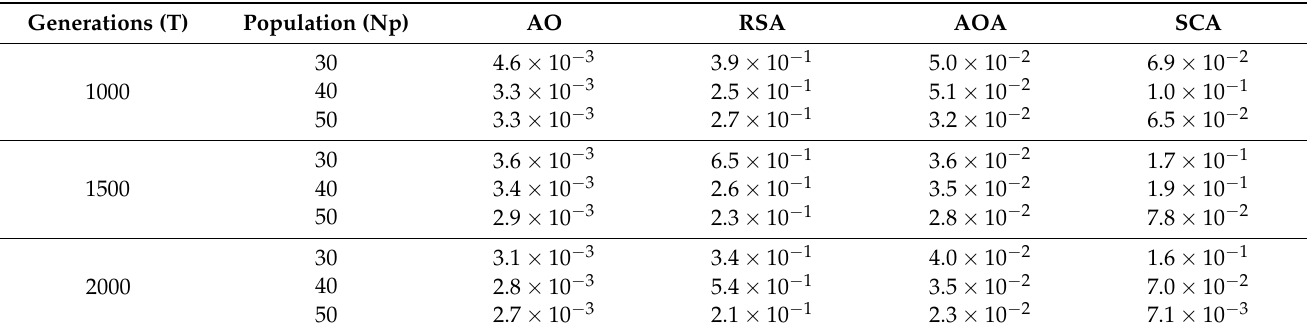
Table 19. Comparison of AO with RSA, SCA, and AOA against average fit for the CAR model at 0.06 noise variance.